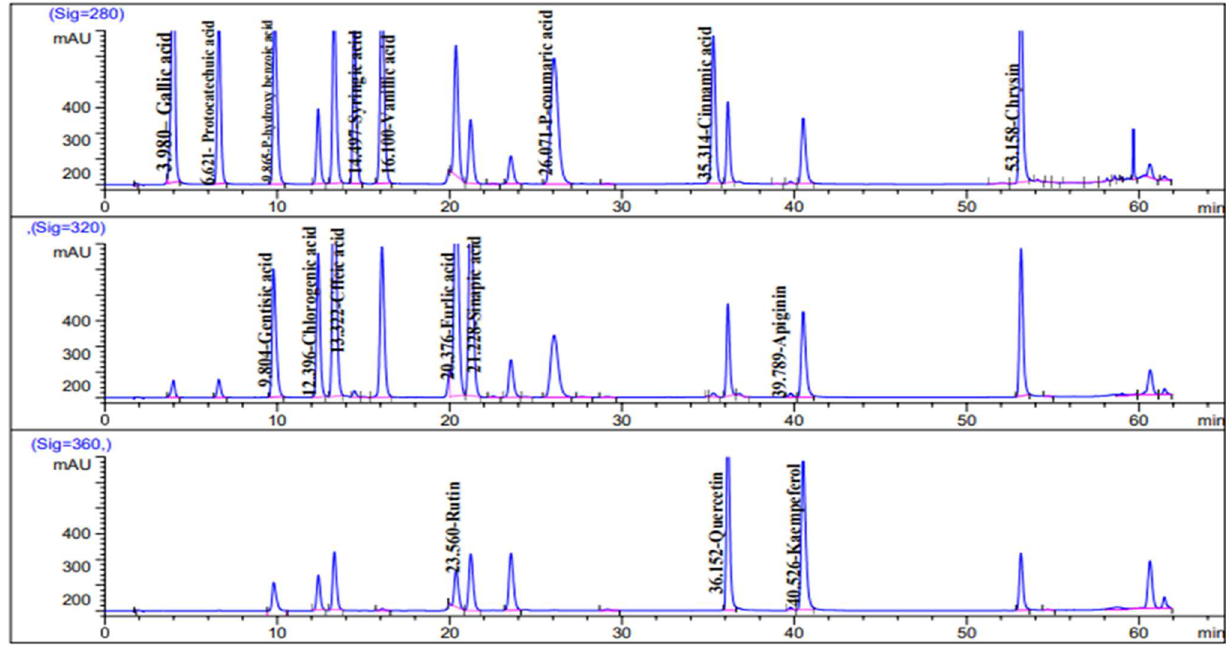
Figure 1. HPLC chromatogram of phenolic compounds (standard mixture).